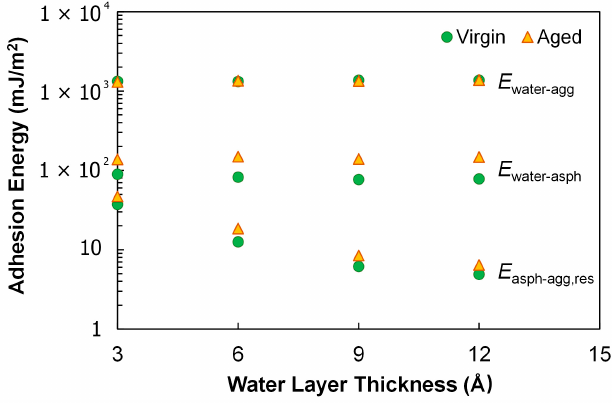
Figure 11. Adhesion energies for the three-layer interface model.